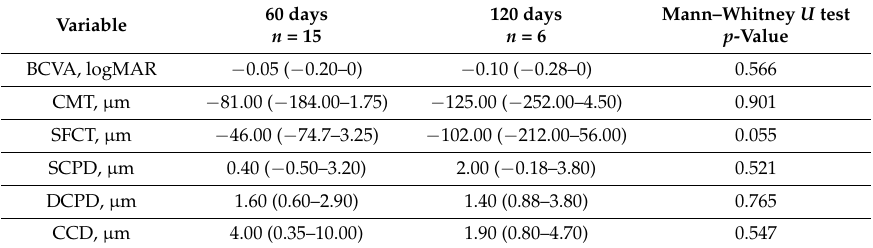
Table 3. Differences in absolute variation between patients with SRF reabsorption after treatment within 60 days and within 120 days expressed as median and interquartile range